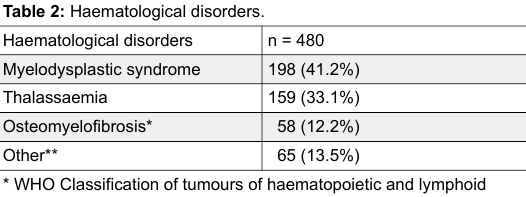
Table 2: Haematological disorders.